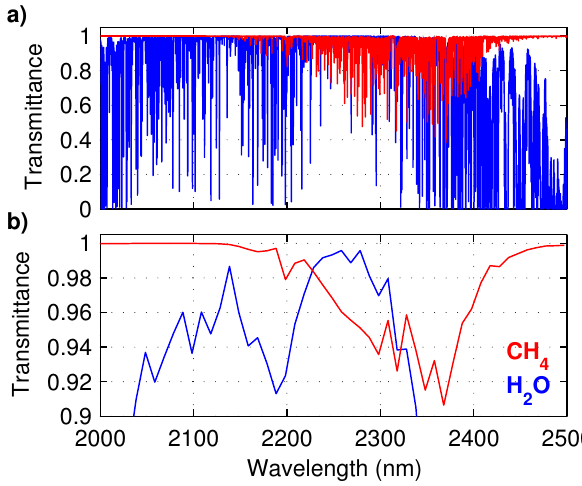
Fig. 1. (a) High resolution CH 4 and H 2 O transmittance. (b) Trans- mittance convolved to the 10nm AVIRIS spectral